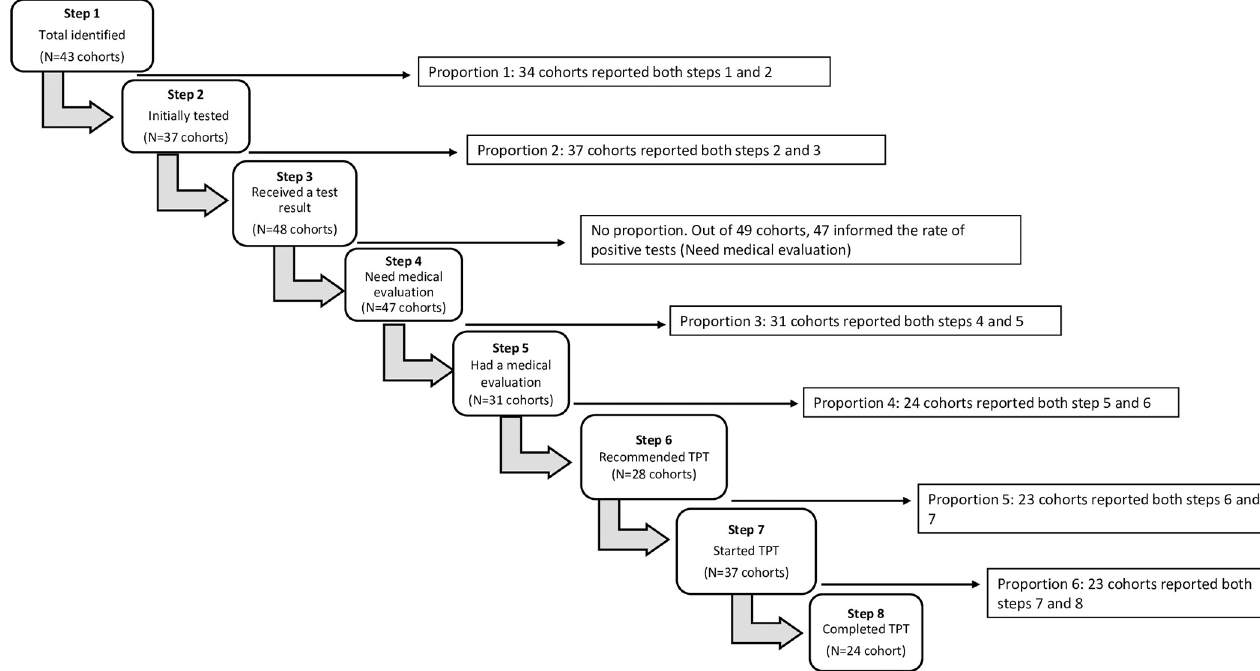
Fig 2. Cascade framework for analysis of cohorts that used LTBI tests ( N = 49 cohorts). LTBI, latent tuberculosis infection; TPT, tuberculosis preventive therapy.